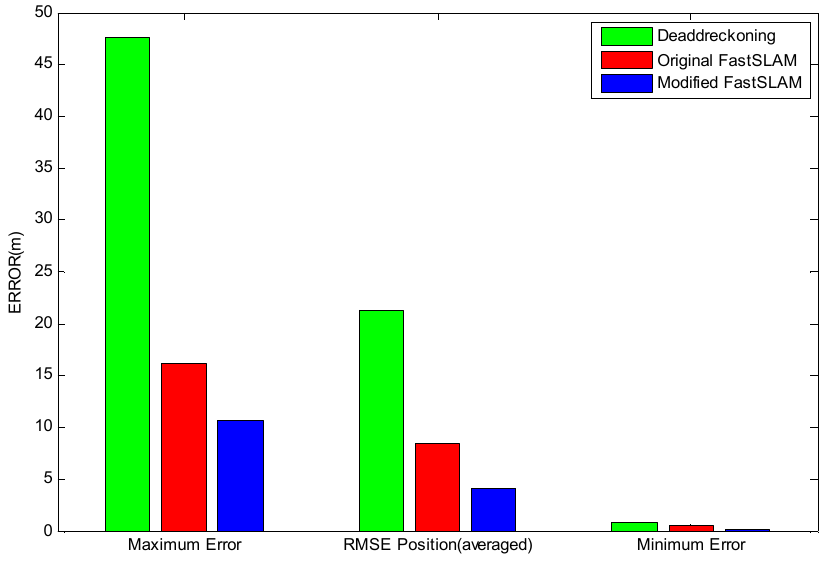
Figure 14. RMSE summarization of Dead-Reckoning, original FastSLAM and modified-FastSLAM over 50